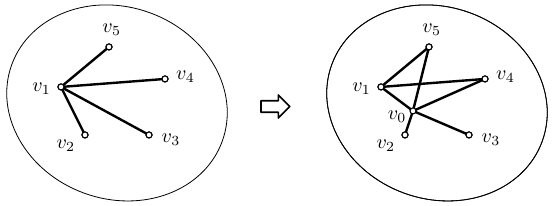
Figure 2: An extension operation which can be considered as a special case of both V-replacement and vertex